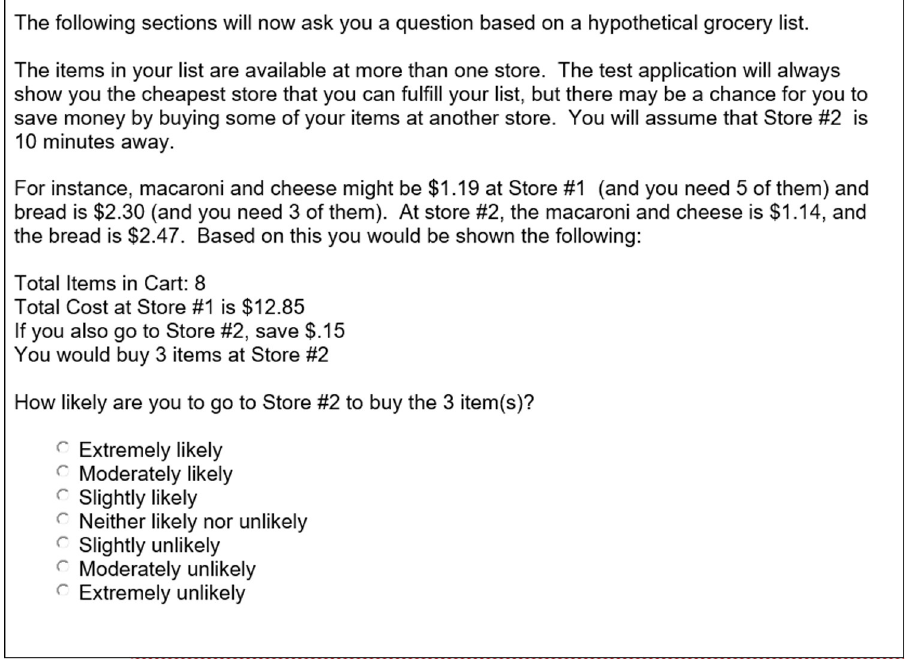
Fig 2. Setup information provided to participants in study 1.